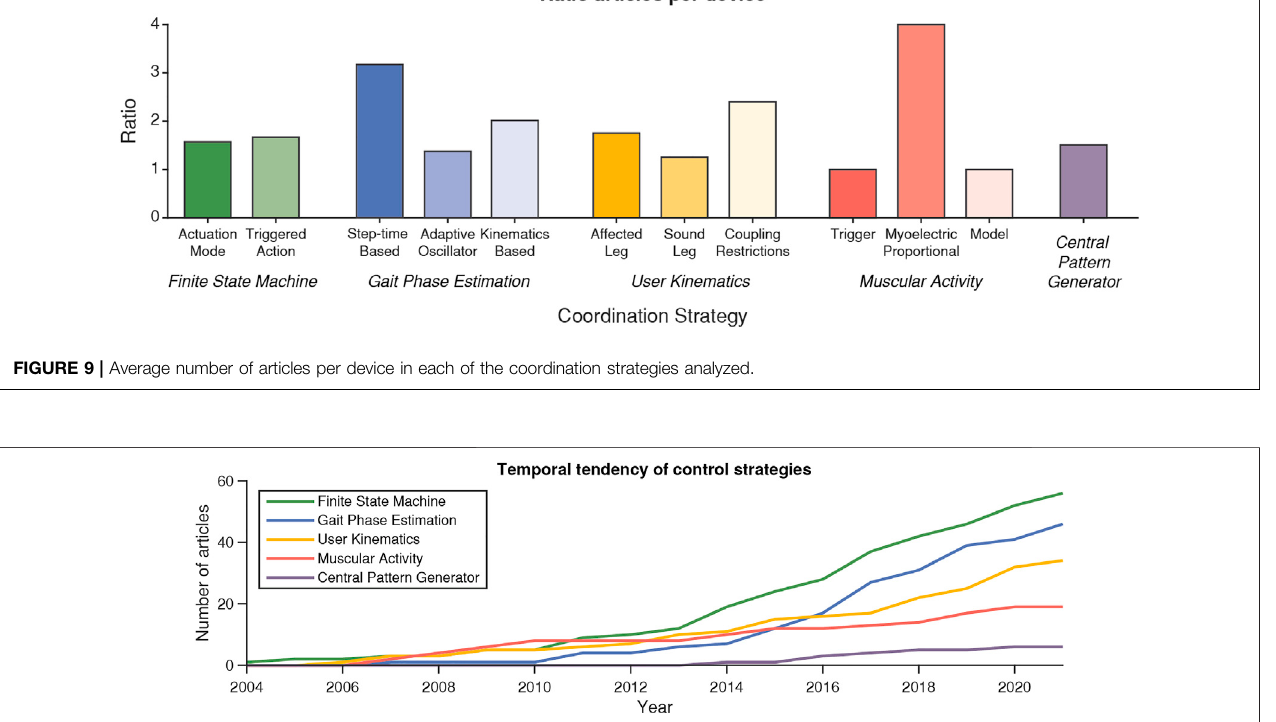
FIGURE 10 | Cumulative frequency of the number of published articles related to each of the identi fi ed coordination methodologies between partial exoskeletons and human movements.